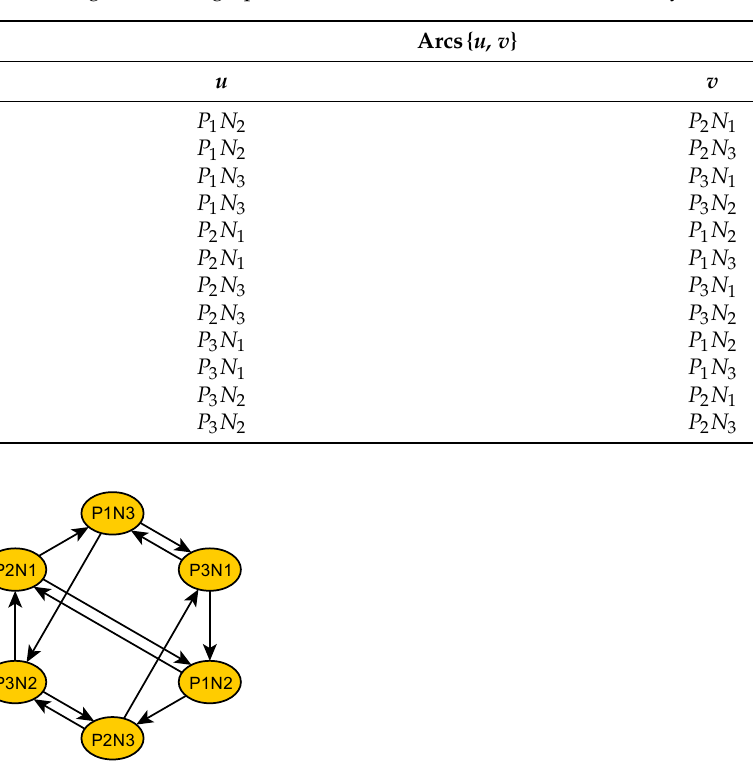
Table 2. Edge list for H graph of the 3-modules CHB-B2B in ISOP array.